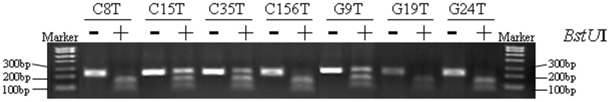
MLH1 promoter methylation assessment by COBRA with BstUI.The four colorectal cancers (C8T, C15T, C35T and C156T) and 3 gastric cancers (G9T, G19T and G24T) were analysed. Symbol “−” means that PCR products were digested without BstUI, and “+” means digestion with BstUI.